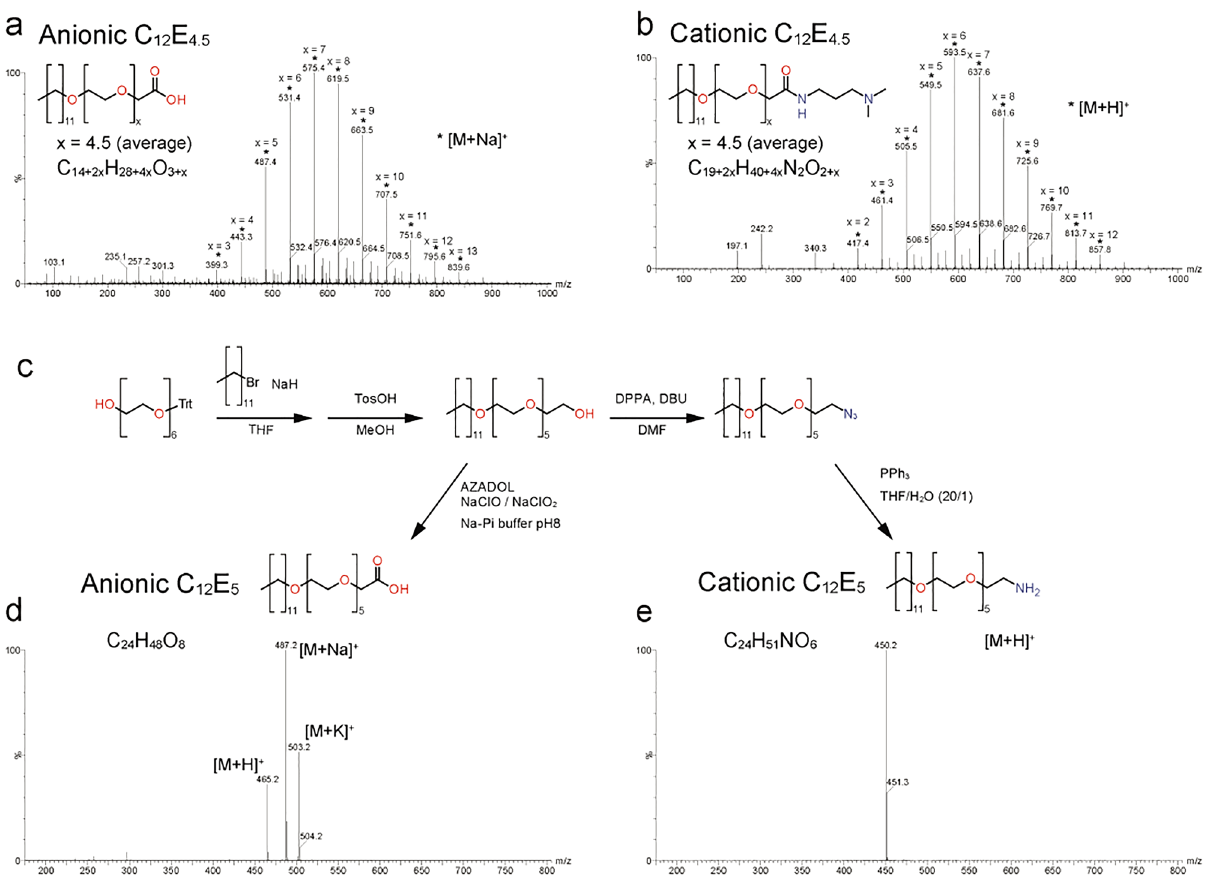
Figure 2. Monodisperse surfactants for the preparation of protein condensate ( a , b ) ES-MS spectra of polydisperse anionic and cationic C 12 E 4.5 surfactants. C 12 E 4.5 surfactants used in previous studies were mixtures with a repeating number of PEG units of 2–13. ( c ) synthesis route of monodisperse anionic and cationic surfactants (the details are described in supplementary information) ( d , e ) ES-MS spectra of monodisperse anionic and cationic C 12 E 5 surfactants.